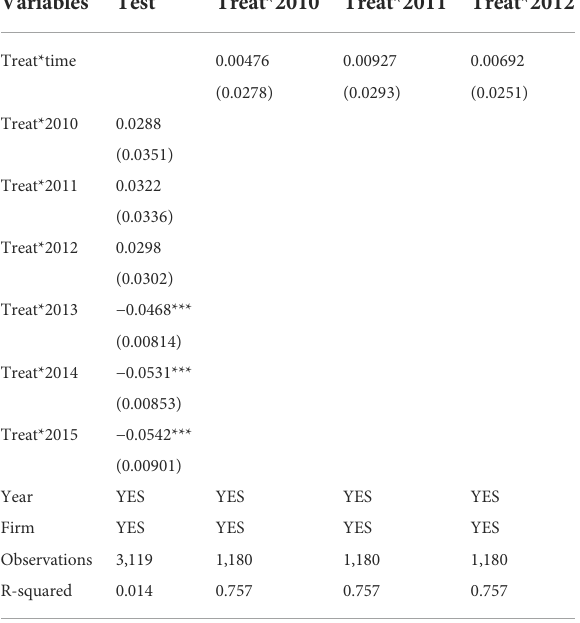
TABLE 6 Test of parallel trend